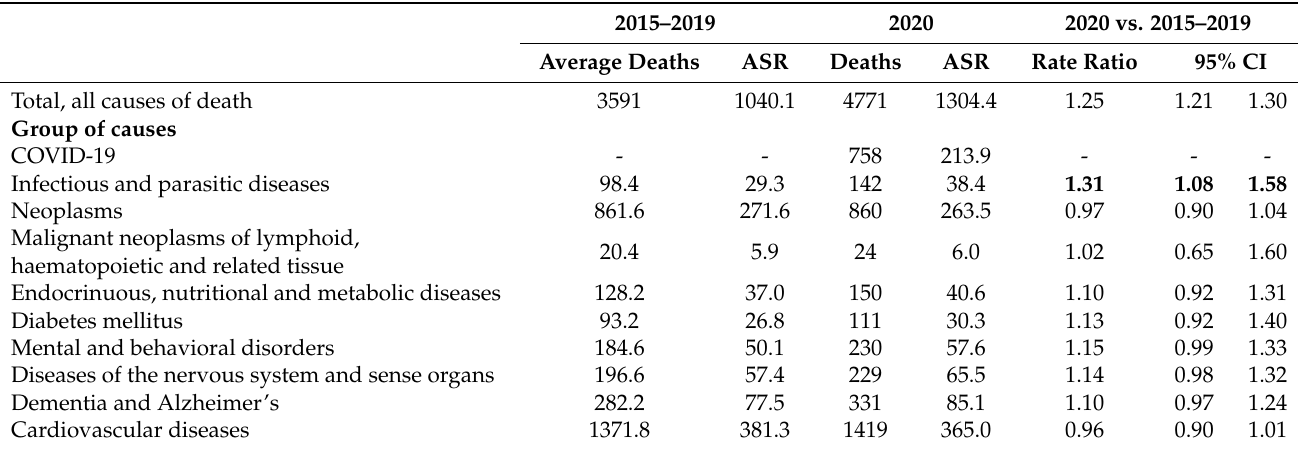
Table 2. Number of deaths and age-standardized 1 mortality rates (ASR) from all causes and groups of causes in women at all ages in 2015–2019 and 2020, the rate ratio and the corresponding 95% confidence interval (CI). Province of Pavia,